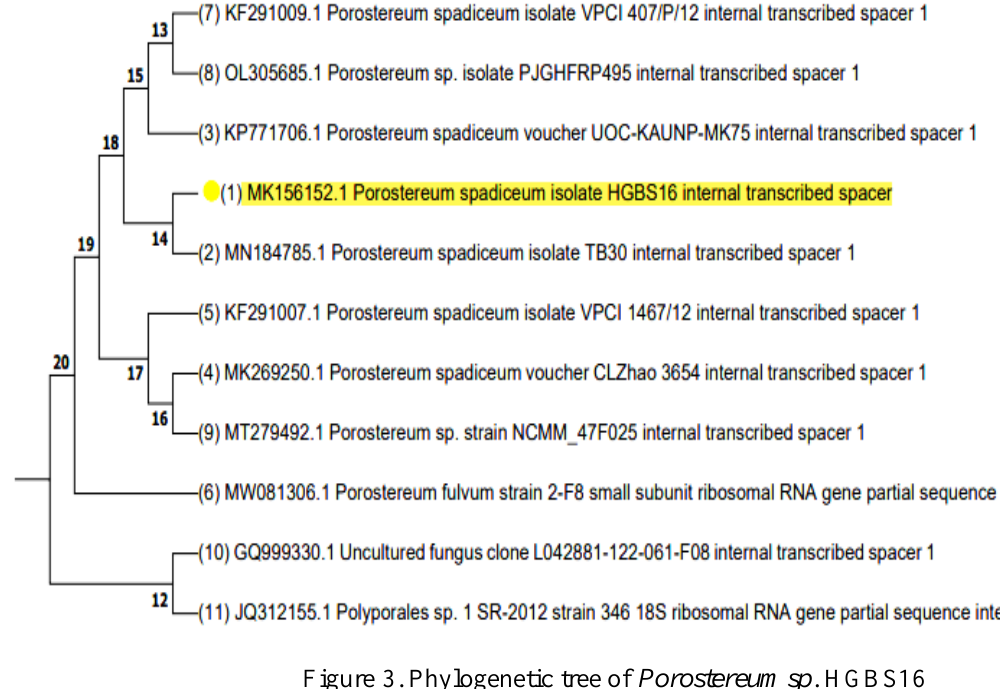
Figure 3. Phylogenetic tree of Porostereum sp . HGBS16 *Yellow color shows the query